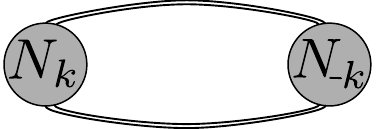
Figure 5: Quiver representation of the ABJM